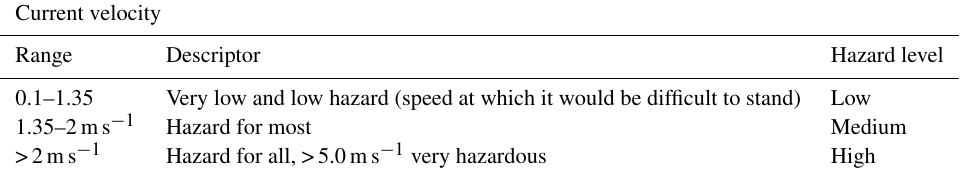
Table 2. Hazard level according to flow current